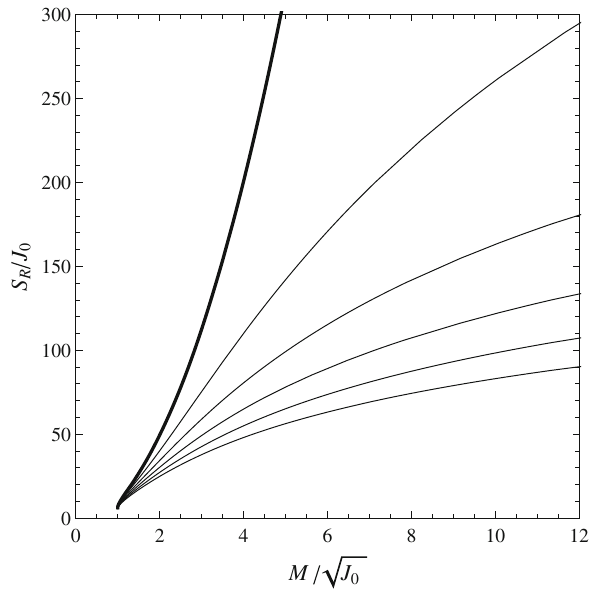
Fig. 3 Plots of the Rényi entropy as a function of the mass-energy parameter at fixed J = J 0 for the parameter values λ J 0 = 0 . 05, 0.04, 0.03, 0.02 and 0.01 starting from the bottom curve, respectively. The top, bold curve belongs to the standard Boltzmann entropy of the Kerr black hole